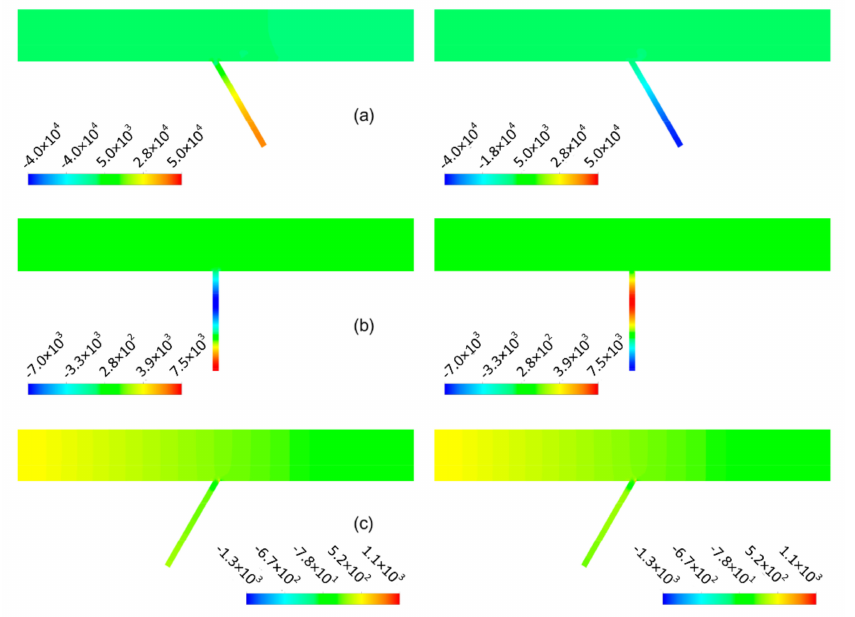
Figure 14. The pressure (unit: Pa) contour at the peak pressure value ( left ) and the nadir pressure value ( right ) of α = 60 ◦ ( a ), α = 90 ◦ ( b ) and α = 120 ◦ ( c ), v = 50